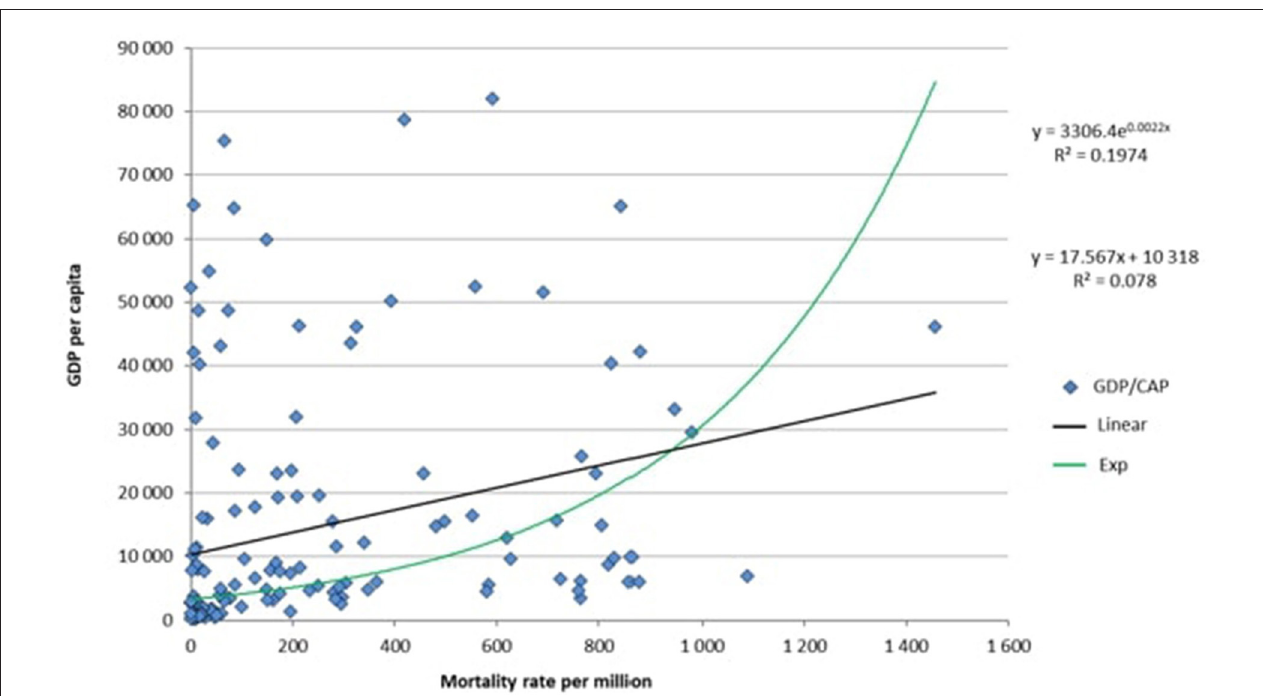
FIGURE 1 | Relationship between GDP per capita and mortality rate per one million inhabitants, for 150 countries with populations of over one million.